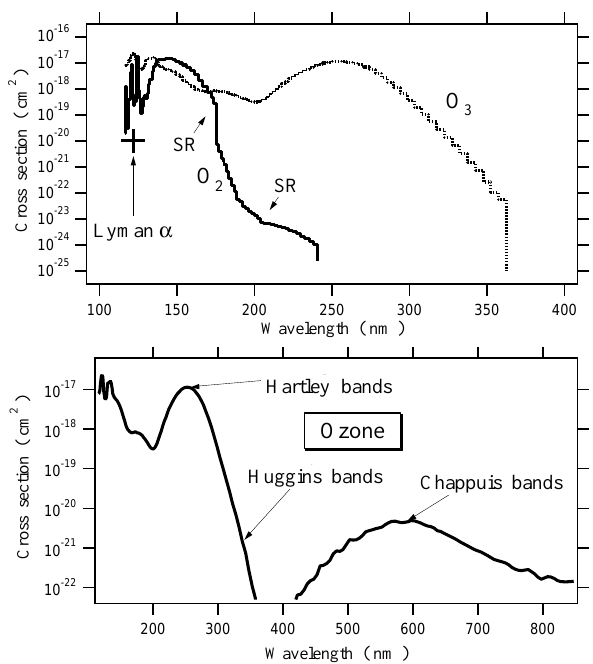
oblique arrows labeled SR show the extent of the Schumann- Runge bands from 204 nm down to 175 nm. The cross sec- tion is highly variable as a function of wavelength and tem- perature, and the values shown in Fig. 7 are only